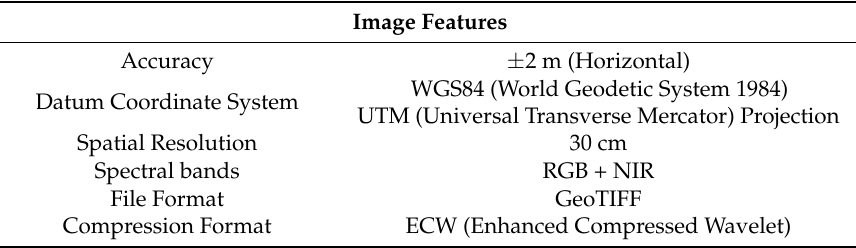
Table 2. Mosaic image features obtained using photogrammetric